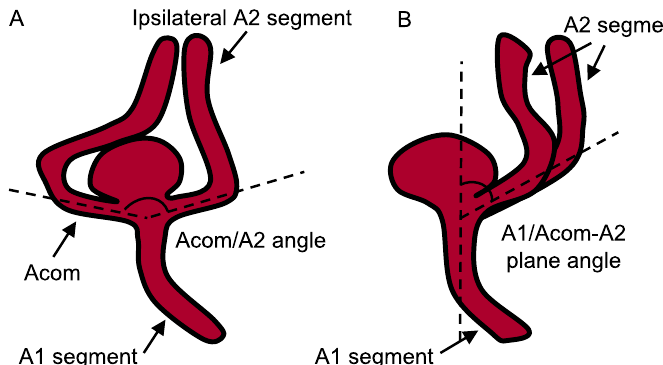
Figure 1. Schematic diagrams showing angle measurement at the anterior communicating artery (Acom)- anterior cerebral artery (ACA) bifurcation. The angles formed between the Acom and the A2 segment (the Acom/A2 angle) ( A ) and between the A1 segment and the plane containing both the Acom and the A2 segment (the A1/Acom-A2 plane angle) ( B ) are